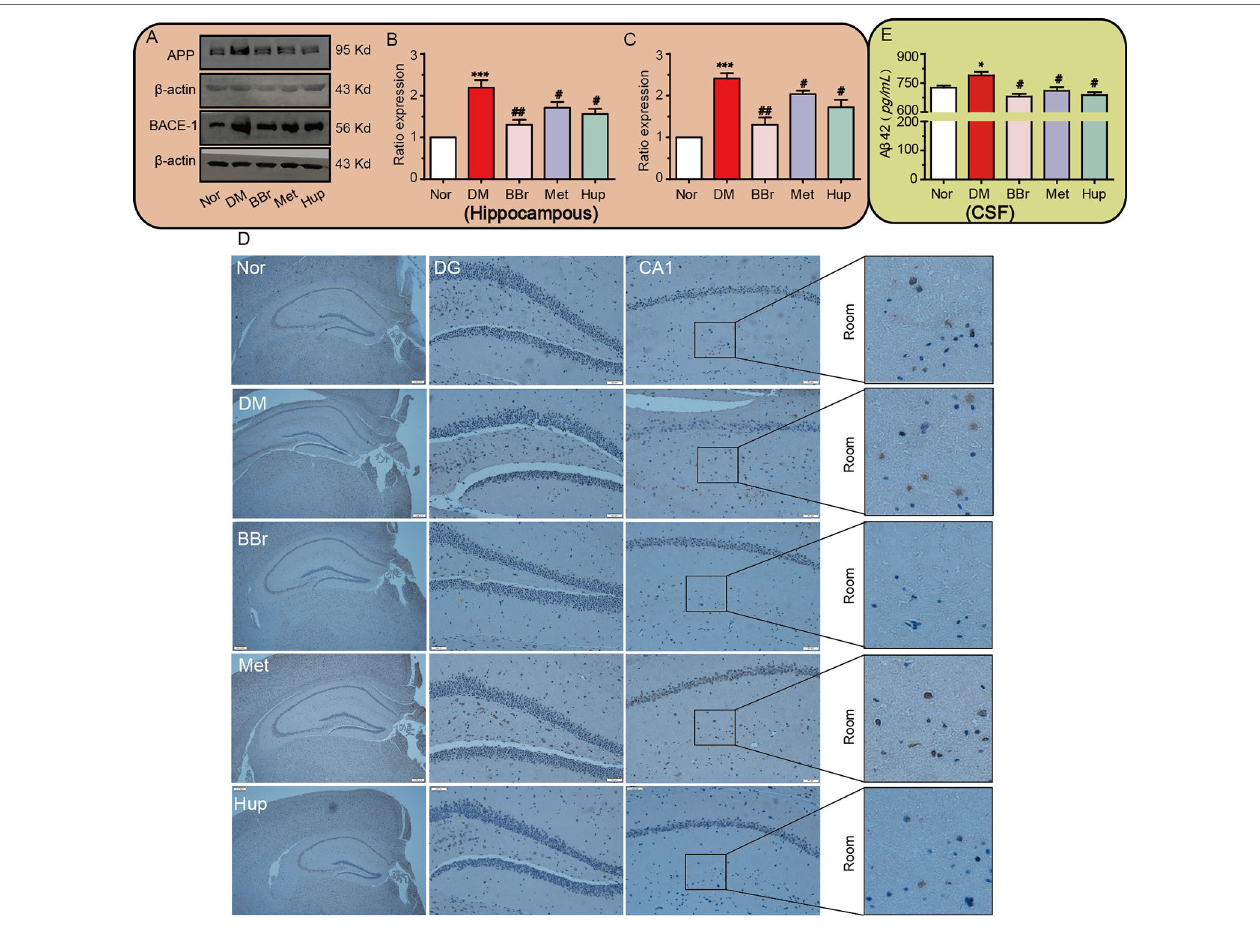
FIGURE 6 | Berberine improves APP misprocessing in the hippocampus. (A – C) APP and BACE-1 expressions were assessed by Western-blot, n = 3. The senile plaque formation is evaluated by Congo red staining, n = 3 (D) . A β 42 levels in CSF were detected using ELISA kits, n = 8–12 (E) . * P < 0.05 vs. Nor; *** P < 0.001 vs. Nor; # P < 0.05 vs. DM; ## P < 0.01 vs.